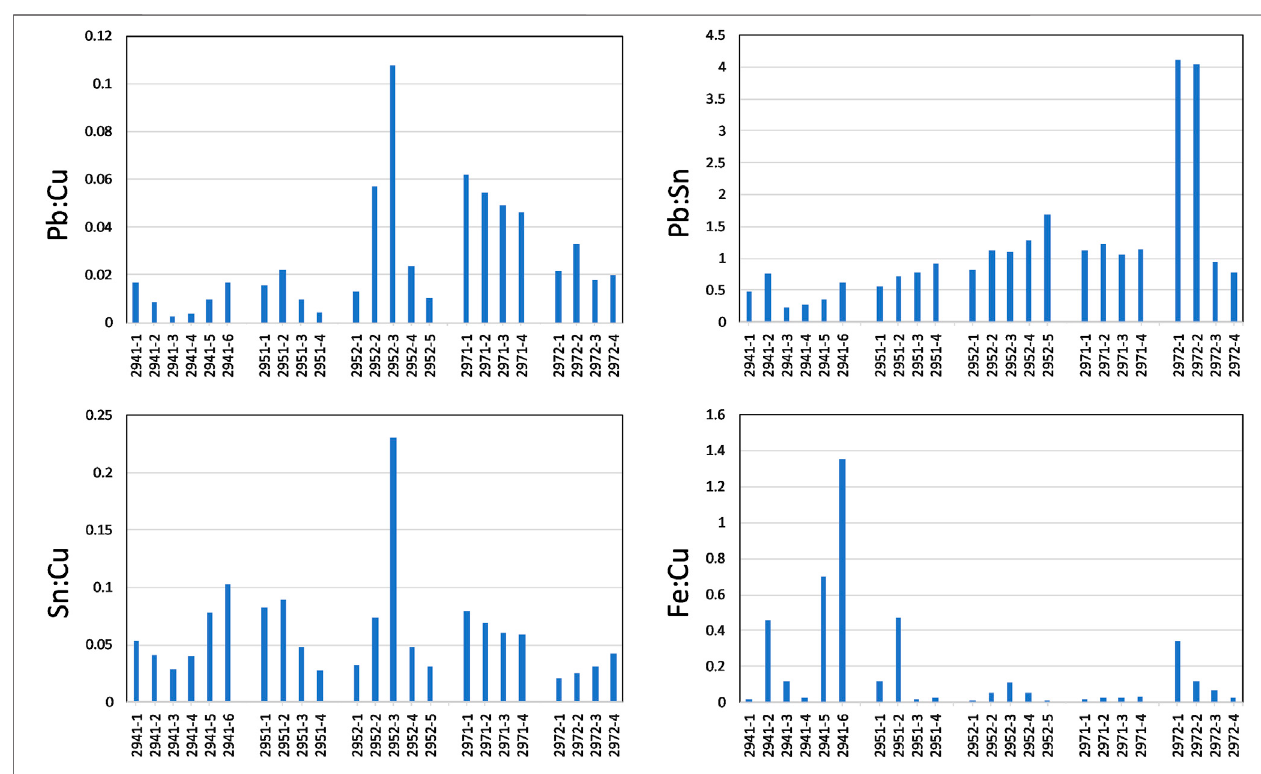
FIGURE 6 | Elemental